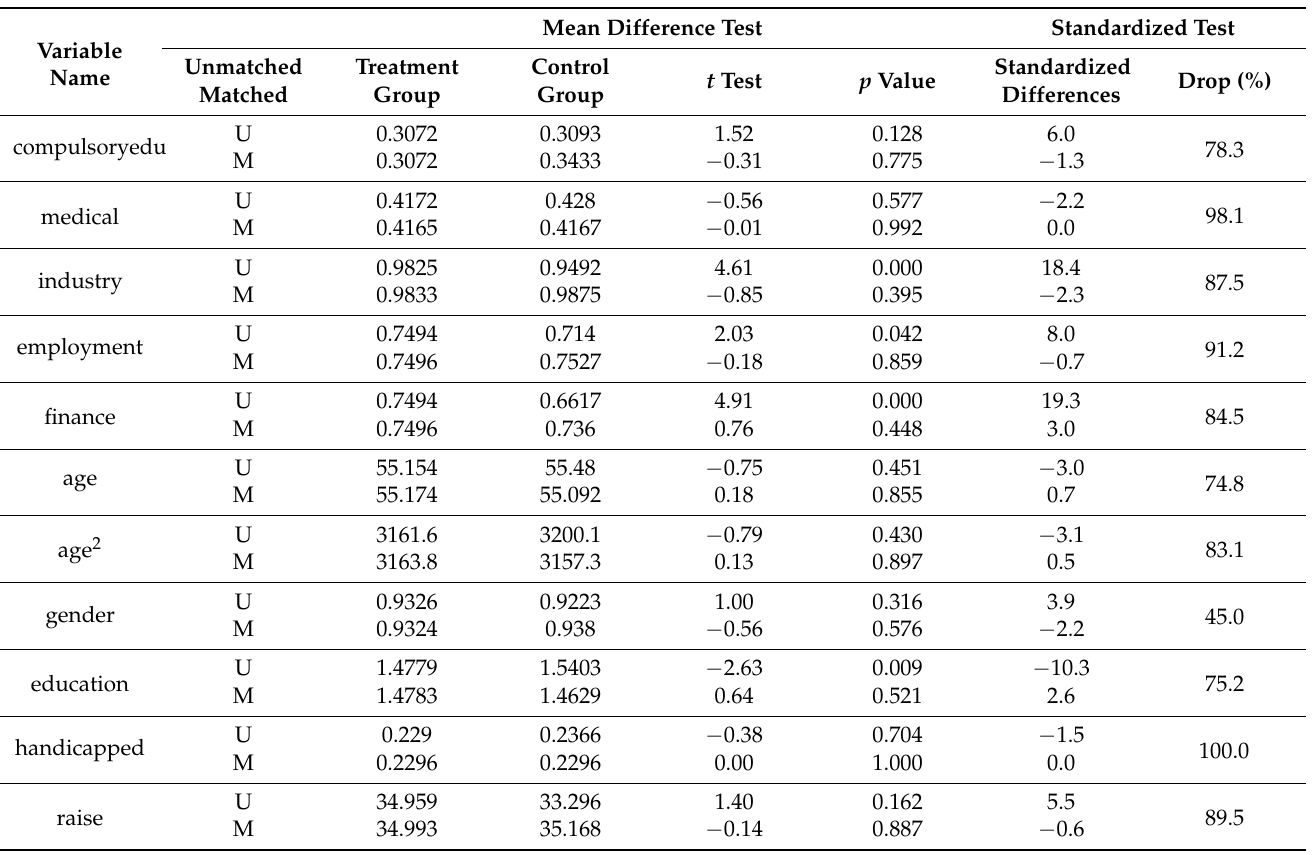
Figure 3. Standardized differences of matching variables before and after matching. Table 5. Balance test results.